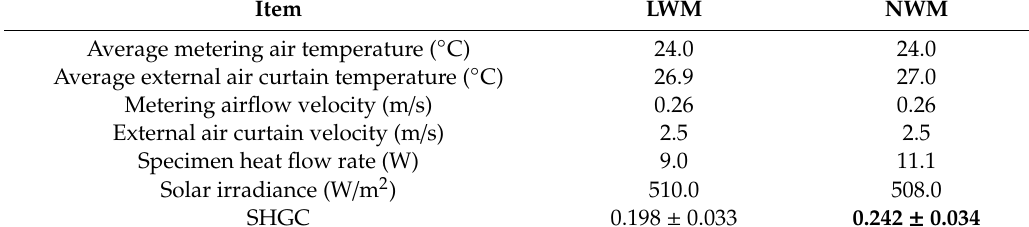
Figure 14. Thermal properties: ( a ) U-value; ( b ) C-value; ( c ) R-value; ( d ) K-value. Table 4. Experimental data. SHGC = solar heat gain coefficient.